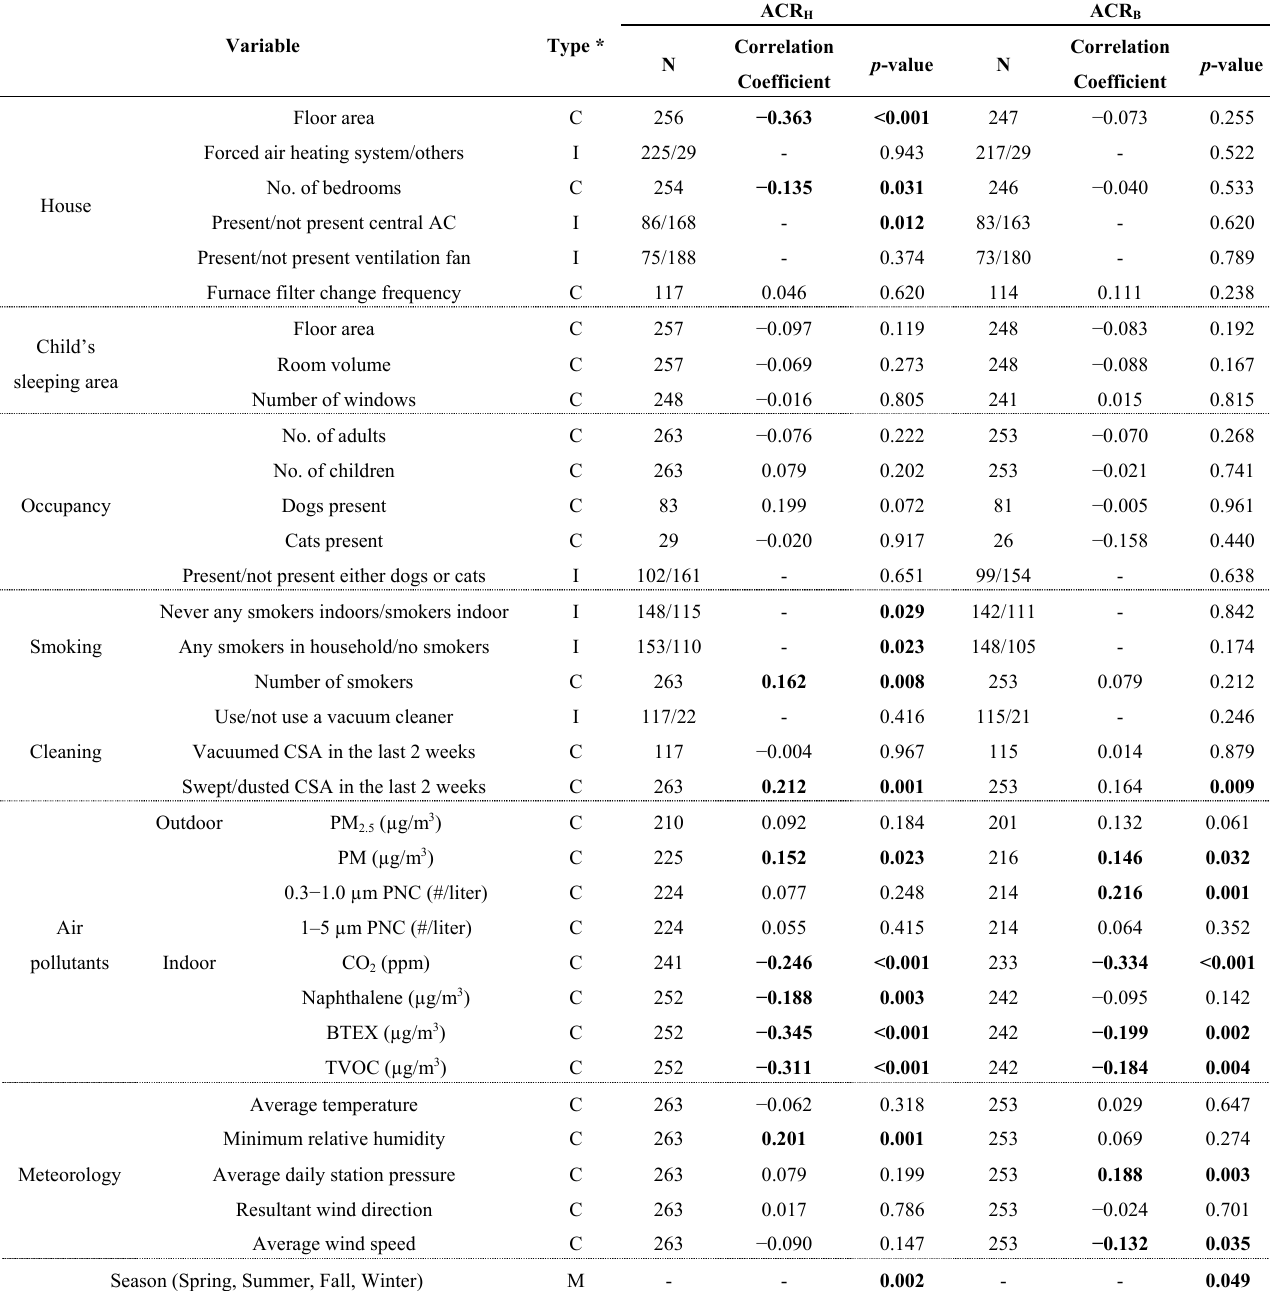
Table 2. Association between ACRs and house and building/occupant characteristics. Spearman correlation coefficients used for continuous variables, and Kruskal-Wallis tests for categorical variables. Statistically significant associations ( p < 0.05) in bold. PNC = particle number count; CSA = child’s sleep area (e.g., bedroom); * C = continuous variable; I = indicator variable; M = multilevel categorical